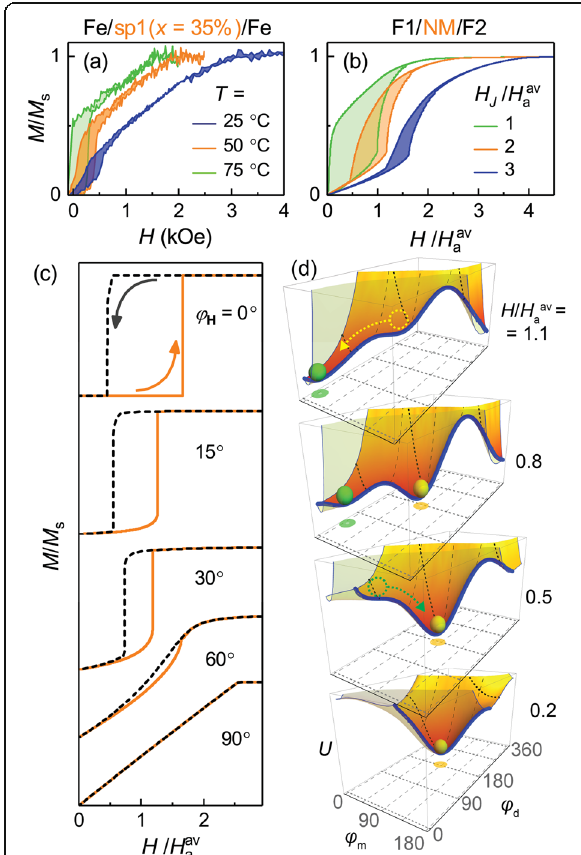
Fig. 3 a Measured M ( H ) curves for a sample from series, Fe/sp1( x = 15%)/Fe, for different temperatures. b Corresponding simulated M ( H ) curves for model F1/NM/F2 trilayer for different strengths of effective field H J of indirect exchange coupling. ( H aav =( H a1 + H a2 )/2, where H H a1 and a2 are anisotropy fields of layers F1 and F2. c simulated for selected angles φ H , for H J / H aav = 2. d Transformation of local minima of free energy (2) as a function of applied field H , for case H J / H aav =2 and φ H =15°. Blue lines trace the path connecting energy minima for different φ m ( φ d ). Front surface of energy surface is transparent for visual clarity of